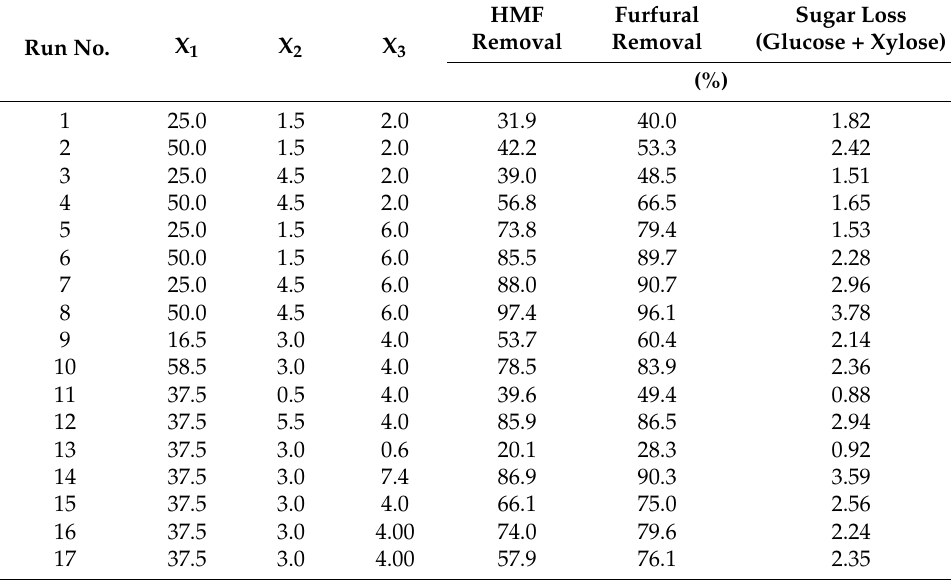
HMF Furfural Sugar Loss Removal Removal (Glucose + Xylose) (%)